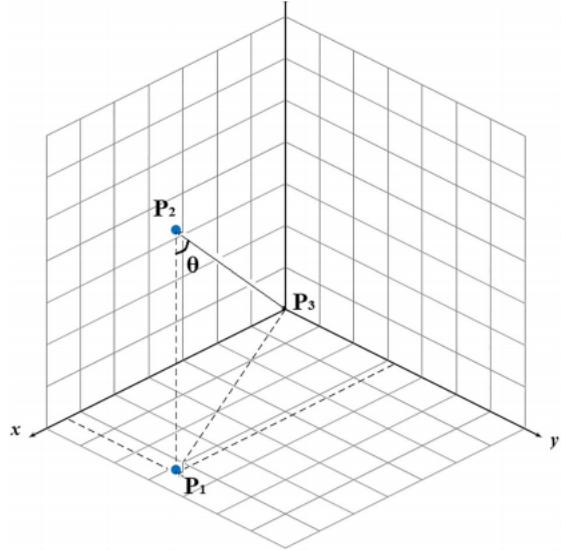
Figure 3. Three coordinates.